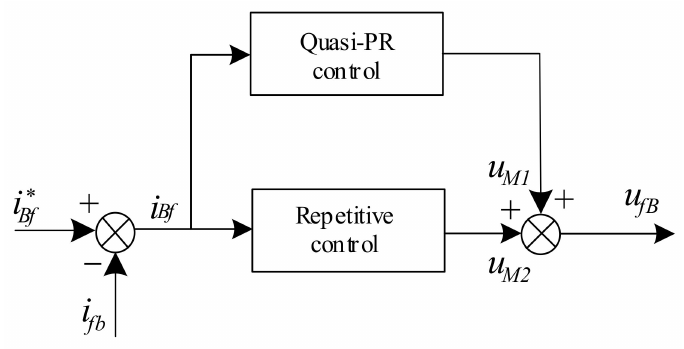
Figure 4. The current tracking unit.